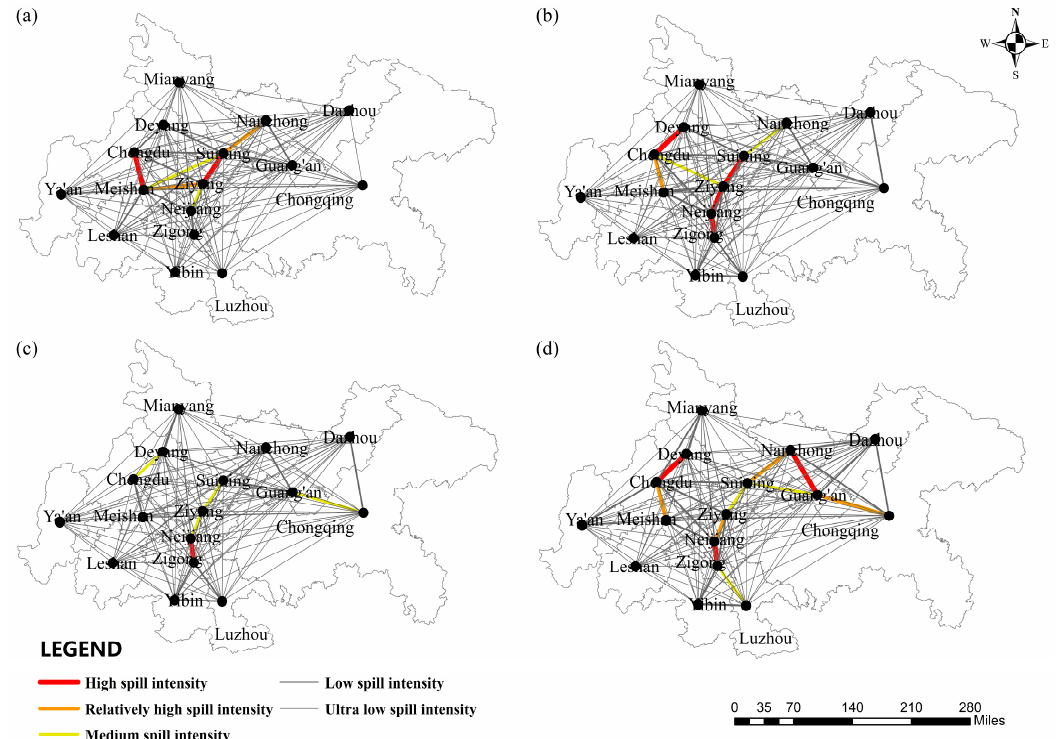
Figure 3. Spatial spillover network structure of green technology innovation efficiency in the Chengdu–Chongqing urban agglomeration. ( a ) 2011. ( b ) 2014. ( c ) 2017. ( d )